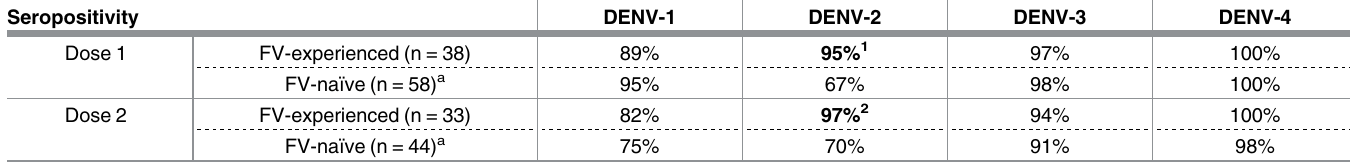
Table 5. Frequency of seropositivity to each DENV serotype after one or two doses of TV003 in subjects who were flavivirus-experienced or -na ï ve a prior to vaccination. Seropositivity DENV-1 DENV-2 DENV-3 DENV-4 Dose 1 FV-experienced (n = 38) Dose 2 FV-experienced (n = 33) FV-na ï ve (n = 44) a Comparison of cumulative seropositivity for each DENV serotype post-TV003 between subjects who were flavivirus-exposed versus flavivirus–na ï ve at Day